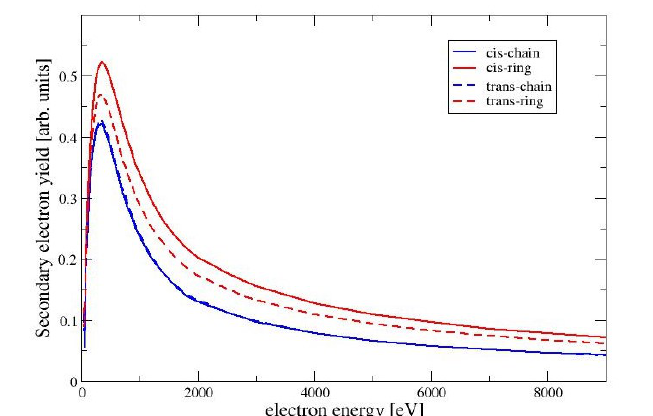
Figure 6. Secondary electron yield as a function of the electron energy for the conformers of MAA.